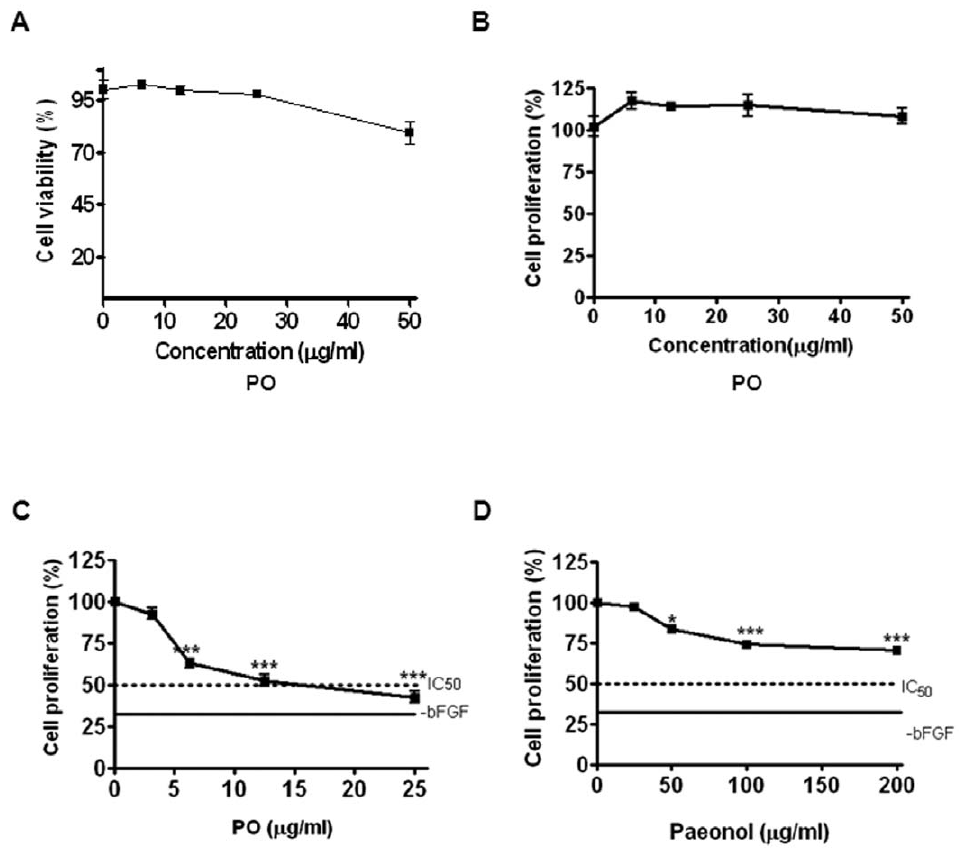
Figure 2. PO inhibits bFGF-induced proliferation of HUVECs. (A) Cytotoxic effect of PO in HUVECs. Cells (5 6 10 3 cells/well) were seeded onto 0.1% gelatin-coated 96-well plates, starved for 6 h in M199 containing 5% heat-inactivated FBS and treated with various concentrations of PO (0, 6.125, 12.5, 25 or 50 m g/ml) for 24 h. Cell viability was measured by MTT assay. (B) Effect of PO on the proliferation of HUVECs. Cells (3 6 10 3 cells/well) were treated with various concentrations of PO (0, 6.125, 12.5, 25 or 50 m g/ml) for 48 h. (C) Effect of PO on the proliferation of bFGF treated HUVECs. Cells (3 6 10 3 cells/well) were treated with various concentrations of PO (0, 6.125, 12.5, 25 or 50 m g/ml) in the absence or presence of bFGF (10 ng/ml) for 48 h. (D) Effect of paeonol on the proliferation of bFGF treated HUVECs. Cells (3 6 10 3 cells/well) were treated with various concentrations of paeonol (0, 25, 50, 100 or 200 m g/ml) in the absence or presence of bFGF (10 ng/ml) for 48 h. Cell proliferation assay was performed using a 5-bromo- 2 9 -deoxyuridine (BrdU) colorimetric assay kit. The statistically significant differences between control and PO treated groups were calculated by the Student’s t- test. * , p , 0.05 and *** , p , 0.001 versus control.